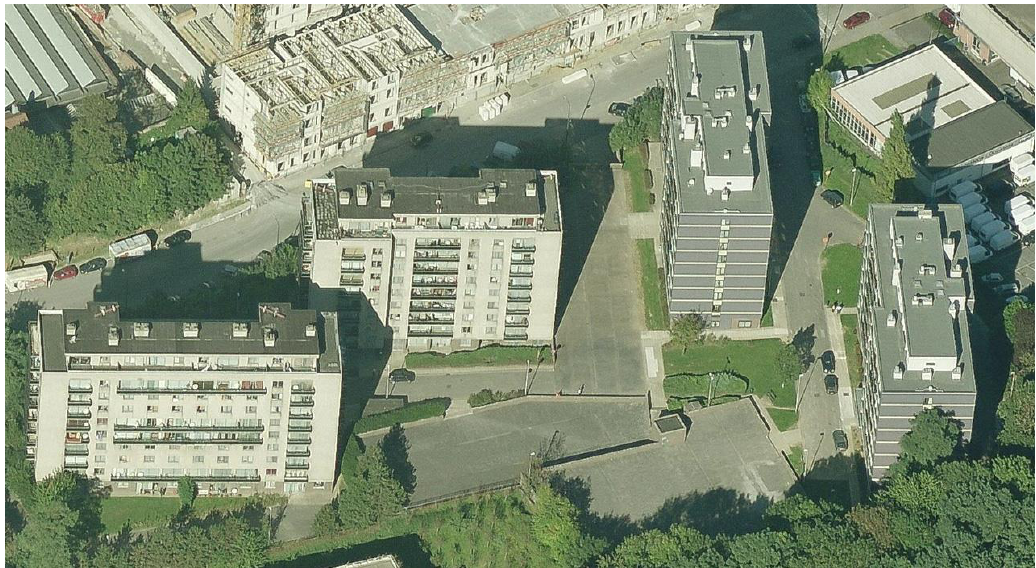
Figure 5 . Evenepoel (2014). Source data: Bing Maps